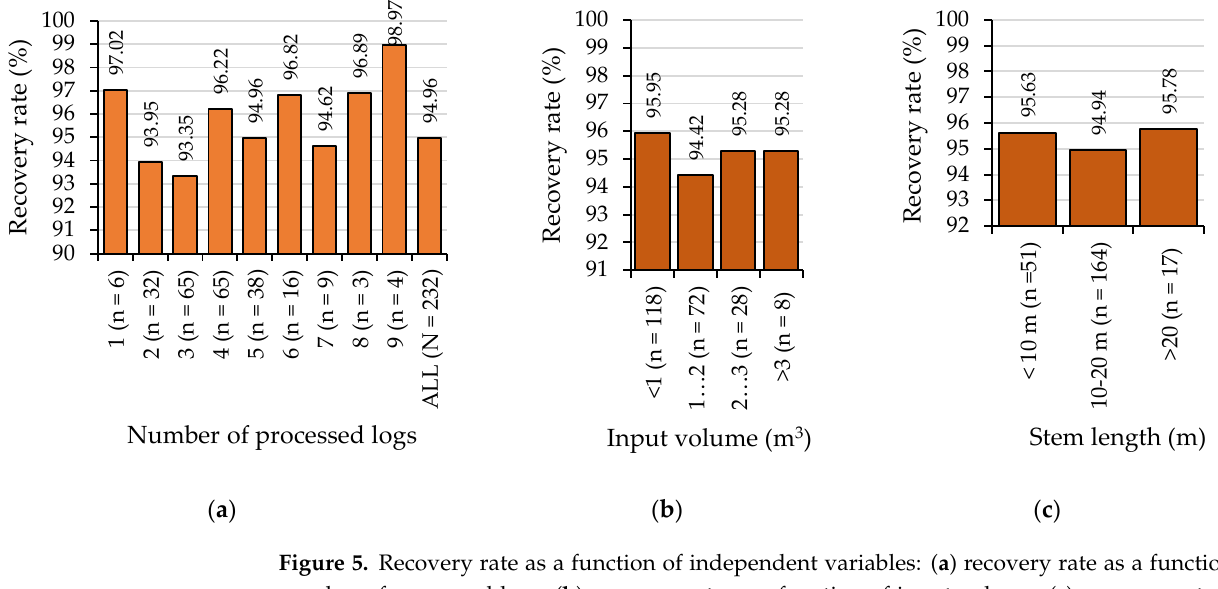
Figure 5. Recovery rate as a function of independent variables: ( a ) recovery rate as a function of number of processed logs, ( b ) recovery rate as a function of input volume, ( c ) recovery rate as a function of stem length.